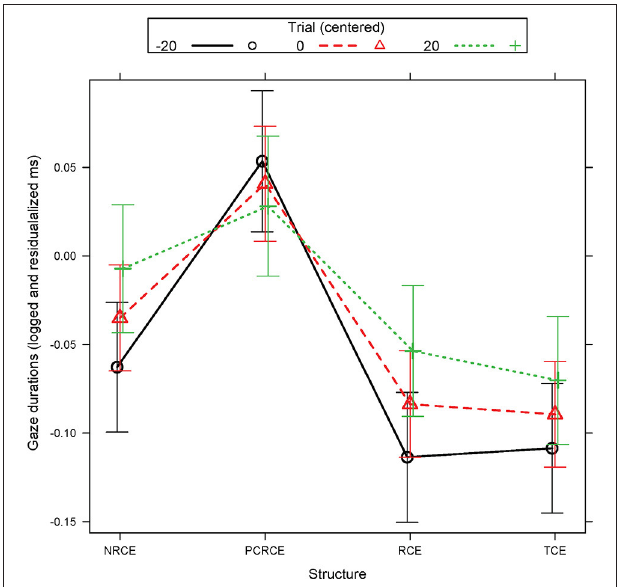
FIGURE 1 | Experiment 1 R01 estimated gaze durations (logged and residualalized ms): Structure by Trial interaction. Error bars represent the 95% confidence interval (CI) of the mean.